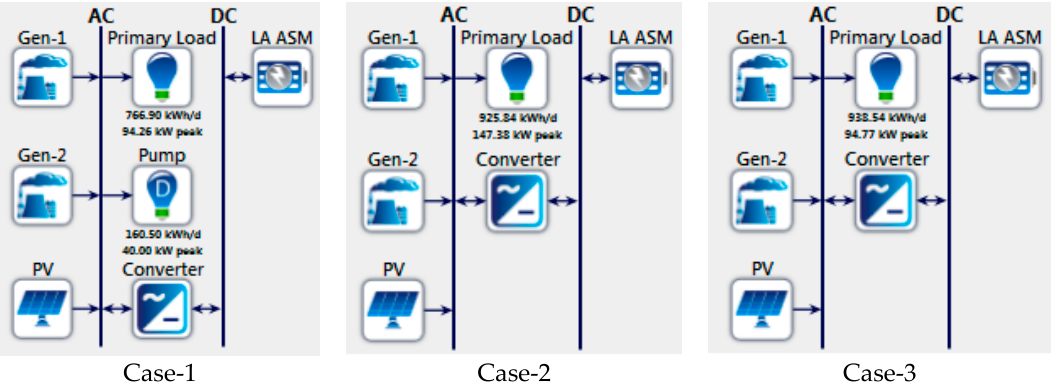
Figure 6. System design for the three selected cases.